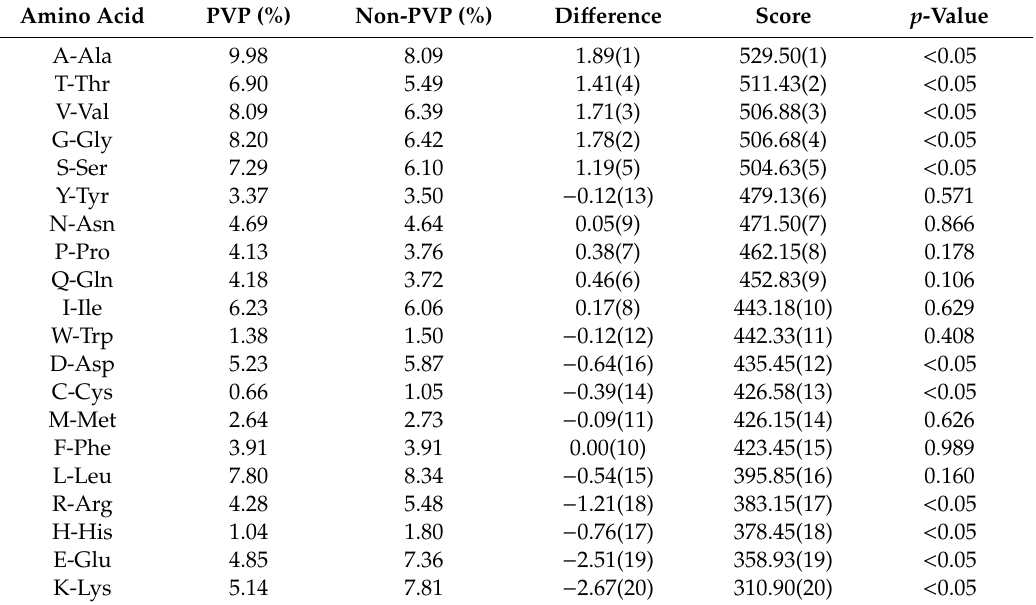
Table 7. The propensity scores of twenty amino acids to be phage virion proteins (score) along with amino acid compositions (%) of PVPs and non-